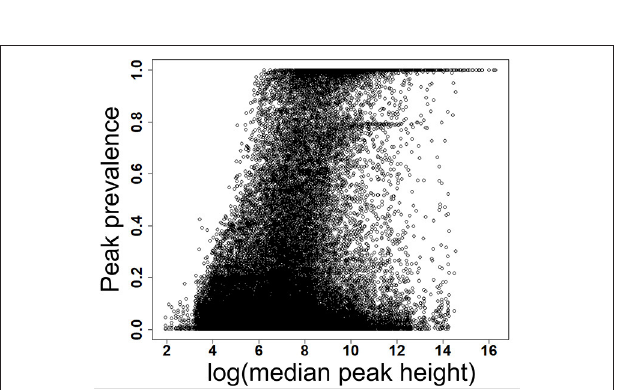
FIGURE 2 | Prevalence of low and high abundant peaks across 499 data files. X-axis shows the scaled detection prevalence, where 1.0 means a peak was detected in all the samples. Y-axis shows the median peak height across all files for a peak. MS-DIAL parameters are available in the Supplementary Table 1